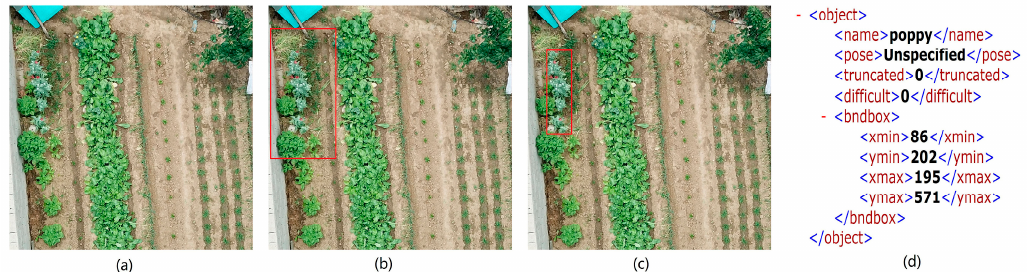
Figure 2. Preliminary processing for poppy selection: ( a ) original images; ( b ) verified images; ( c ) labeled images; ( d ) labeled information.